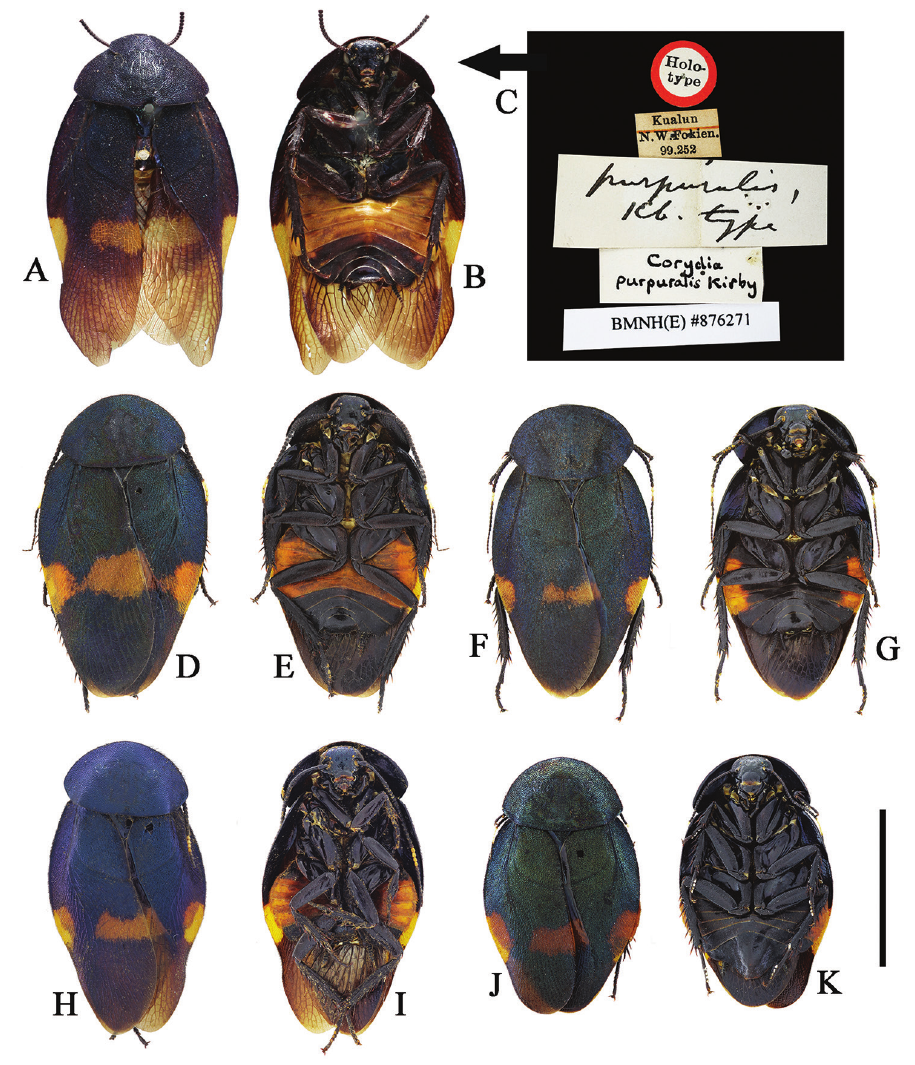
Figure 5. A–K Eucorydia dasytoides , the purpuralis population A–C holotype of Corydia purpuralis: A–B habitus, male C label [ A–C photographed by Zong-Qing Wang, copyright The Natural History Museum, United Kingdom (NHM)] D–E male, from Mt. Wuyishan, Fujian F–I males, from Mt. Tian- mushan, Zhejiang J–K female, from Mt. Dapanshan, Zhejiang. Scale bar 10 mm.